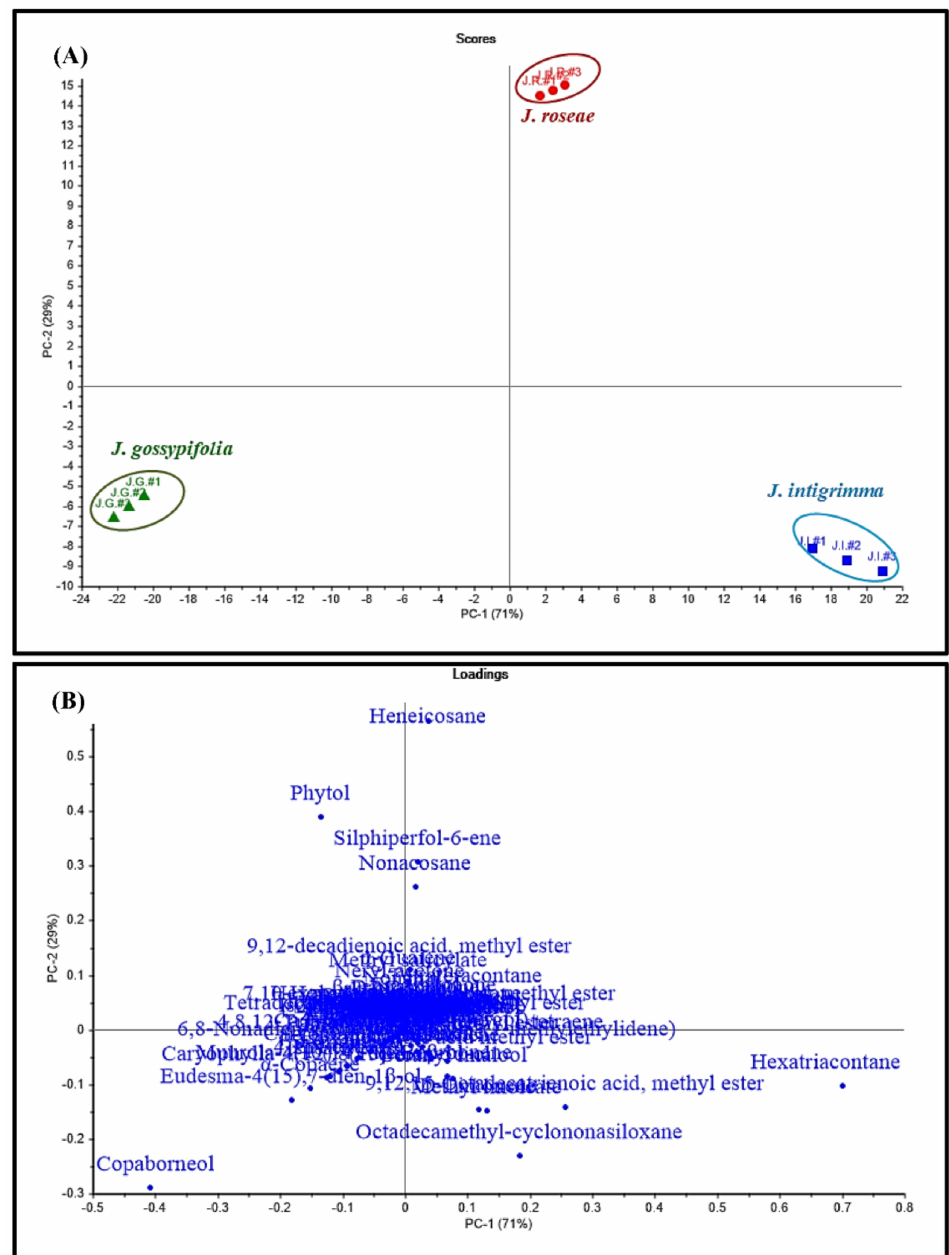
Figure 3. Score plot ( A ) and loading plot ( B ) of GC data collected from J. intigrimma , J. gossypifolia and J. roseae leaves essential oil analyses using unsupervised chemometric analysis